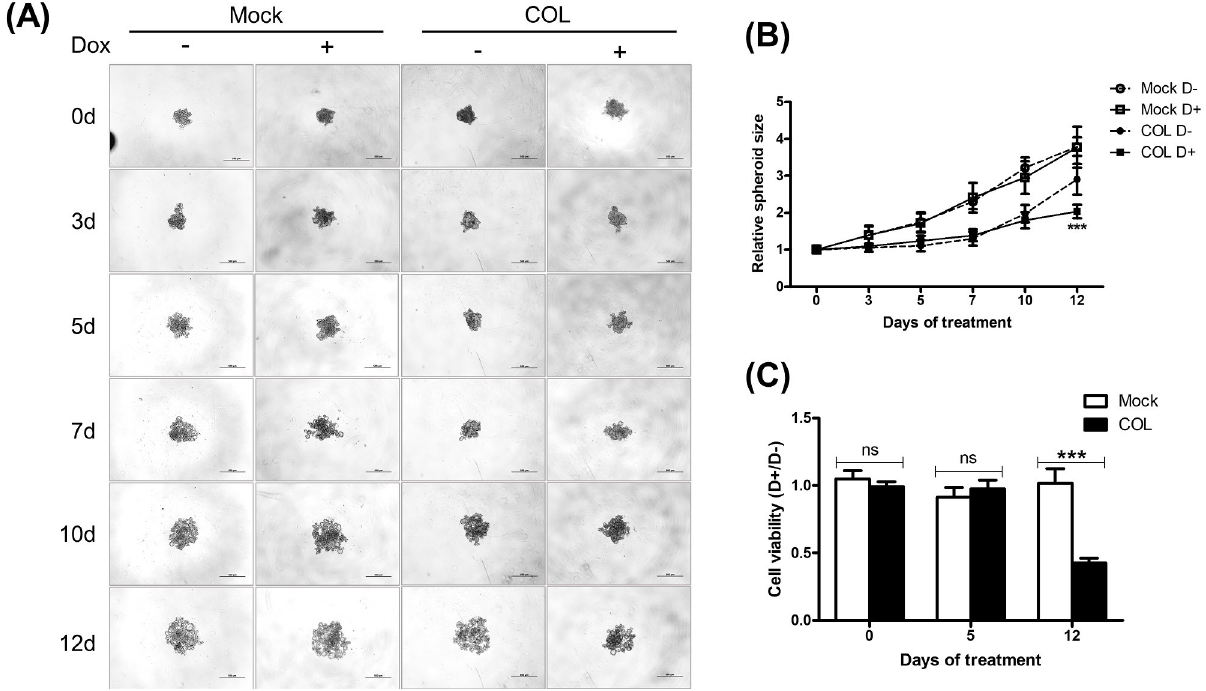
Fig 4. COL17 reduces the spheroid size and proliferation in 3D culture. MCF7/COL (COL) and mock cells were grown in ultra-low attachment 96-well plate for 48 hours and then treated with 0.1 μ g/ml of doxycycline (Dox, D+) or not treated (D − ). (A) The time-course representative images of MCF7 spheroids before and at 3, 5, 7, 10 and 12 days of Dox treatment. The images were taken by a phase-contrast microscope at 10 × magnification. The scale bars indicate 500- μ m length. (B) The spheroid area, excluding the intra-spheroid spaces, was measured by ImageJ software and displayed as spheroid size at 3, 5, 7, 10 and 12 days of treatment, relative to that before the treatment ( n = 5 biological replicates). The statistical difference was compared between treated and untreated cells at each timepoint. Two-tailed Student’s t -test, ��� P < 0.0001; no star, P � 0.05. (C) Cell viability of COL and mock spheroids was evaluated by 3D ATP assay at 0, 5, and 12 days of treatment ( n = 5 biological replicates). The ratio of cell viability between D + and D − groups is shown. Two-tailed Student’s t -test, ��� P < 0.0001; ns, P � 0.05.